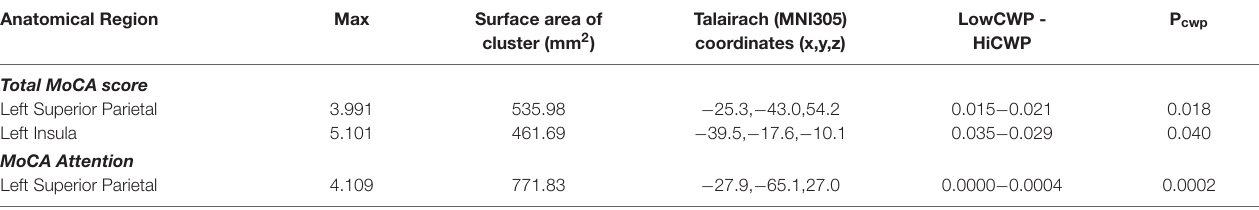
Talairach (MNI305) LowCWP - P cwp cluster (mm 2 ) coordinates (x,y,z) HiCWP